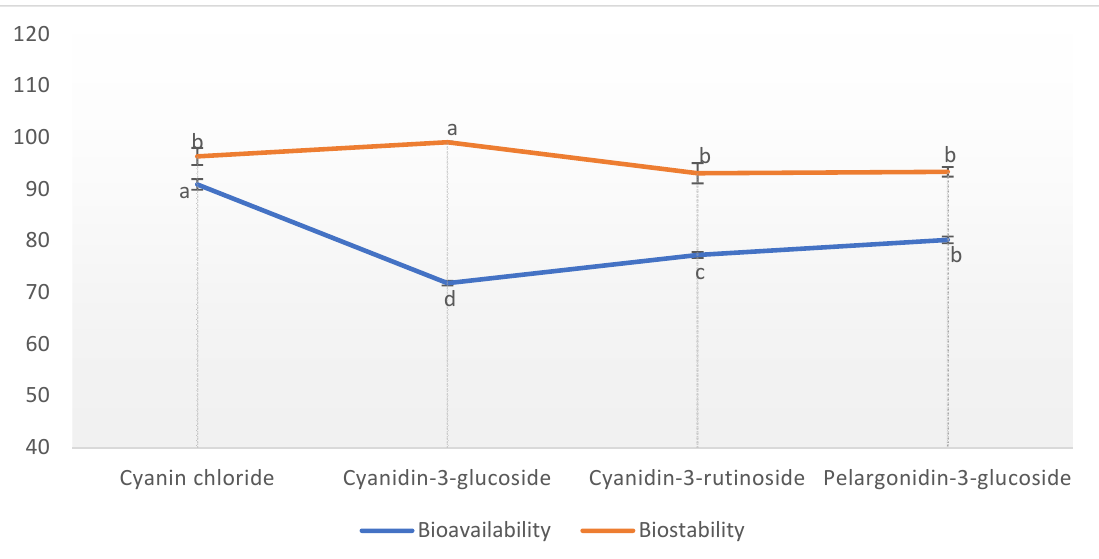
Figure 6. Bioavailability and stability of the individual anthocyanins extracted from borage using CHGLY. a–d = Different lowercase letters on the graphics indicate significant differences ( p < 0.05).